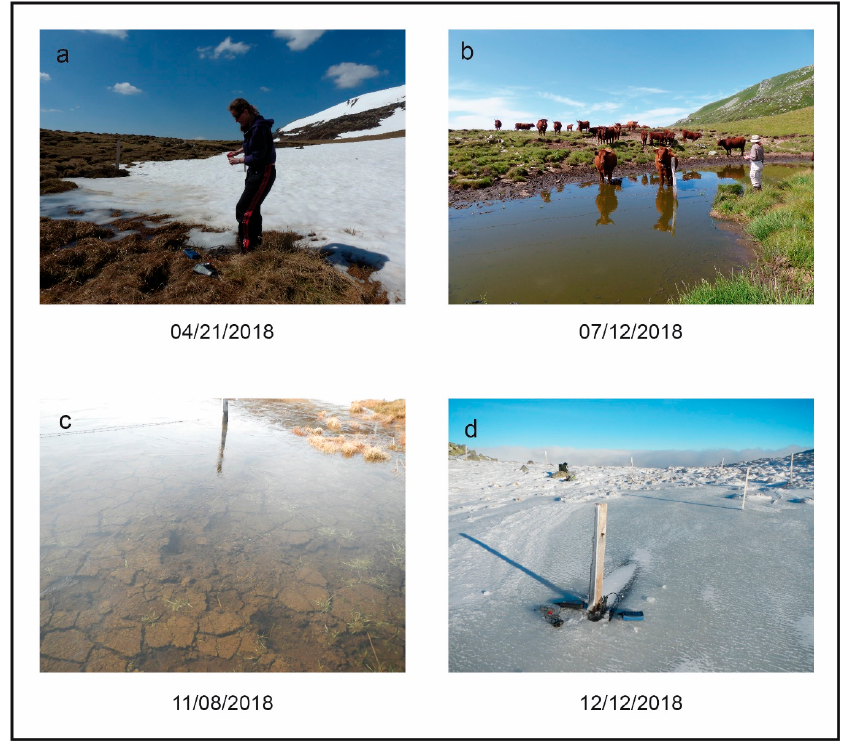
Figure 2. Field survey performed in April ( a ), July ( b ), November ( c ), and December ( d )